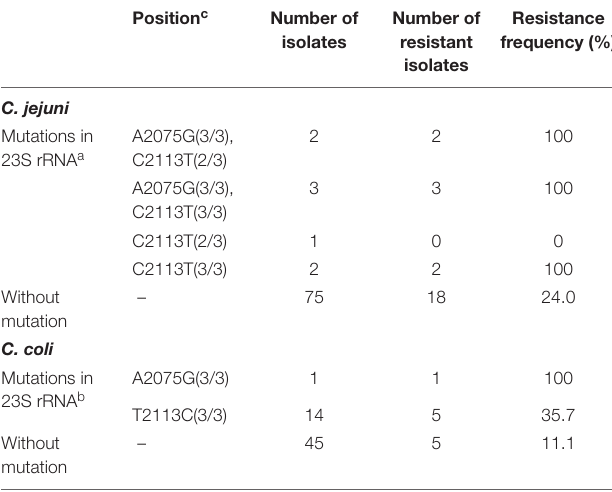
TABLE 1 | Polymorphisms on the 23S rRNA gene of C. jejuni and C. coli isolates.